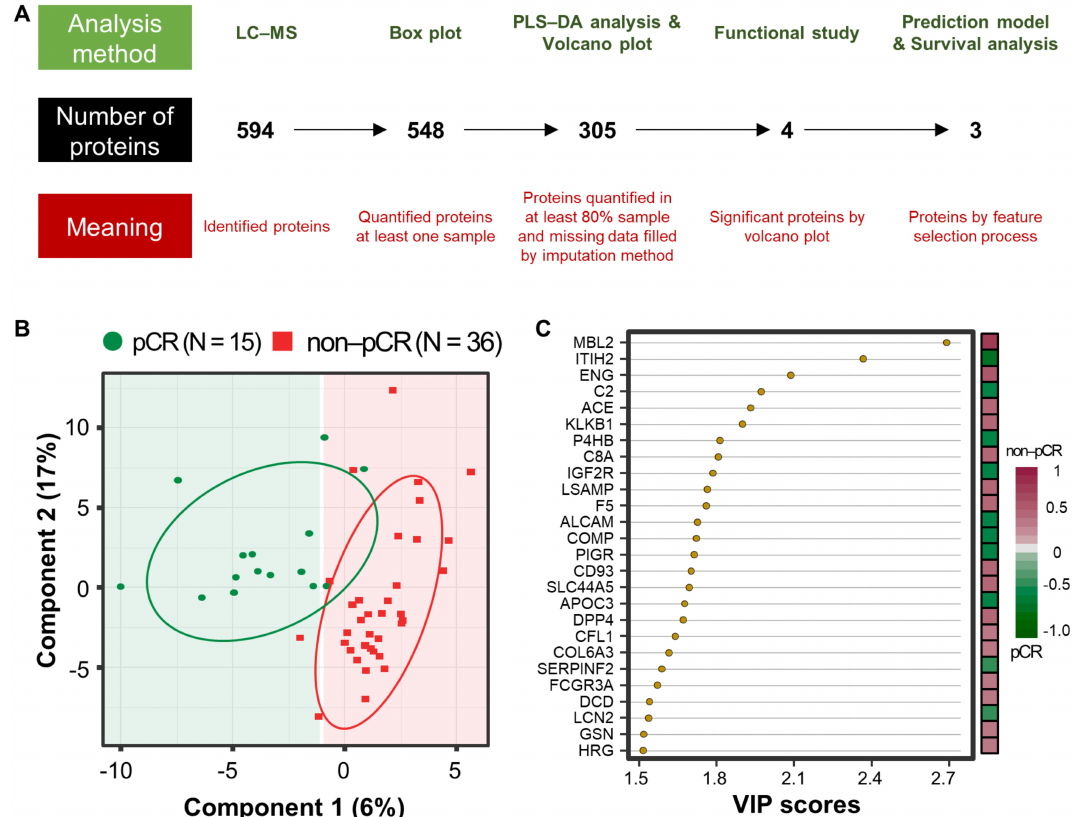
Figure 1. Analysis workflow and partial least-squares discriminant analysis (PLS-DA) of plasma proteomes in 51 breast cancer (BC) patients. ( A ) The analysis method is shown at the top, the number of proteins is shown in the middle, and the meaning of the step is shown at the bottom. PLS-DA score plot ( B ) and top26 variable importance in projection (VIP) score (>1.5) plot derived from PLS-DA analysis ( C ) in 15 patients with pathological complete response (pCR; green) after neoadjuvant therapy and 36 patients with non-pCR (red).